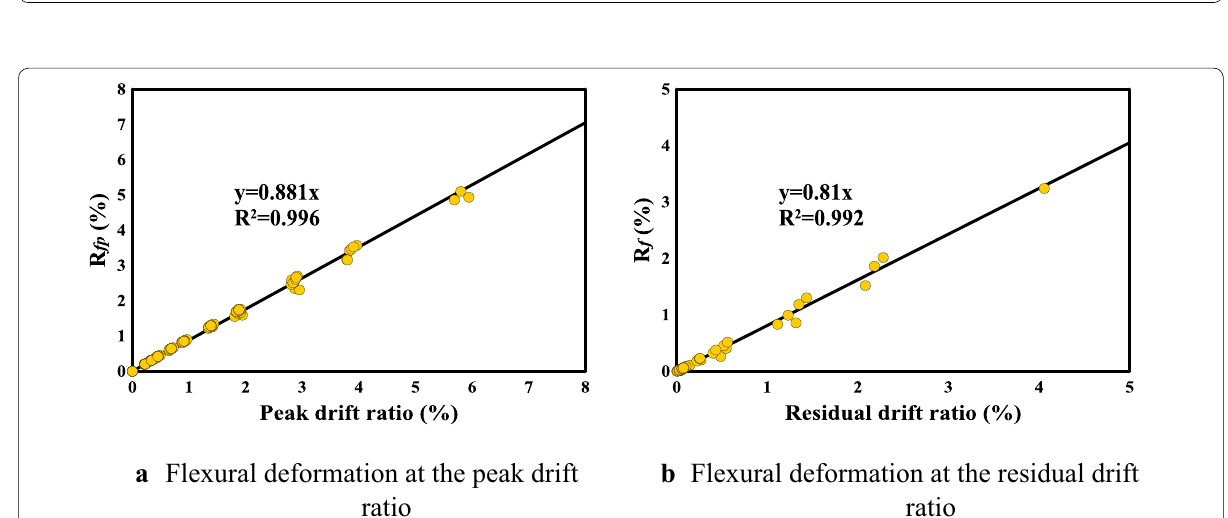
Fig. 11 Specimen of SF‑30S‑0.1 and SF‑30S‑0.2.